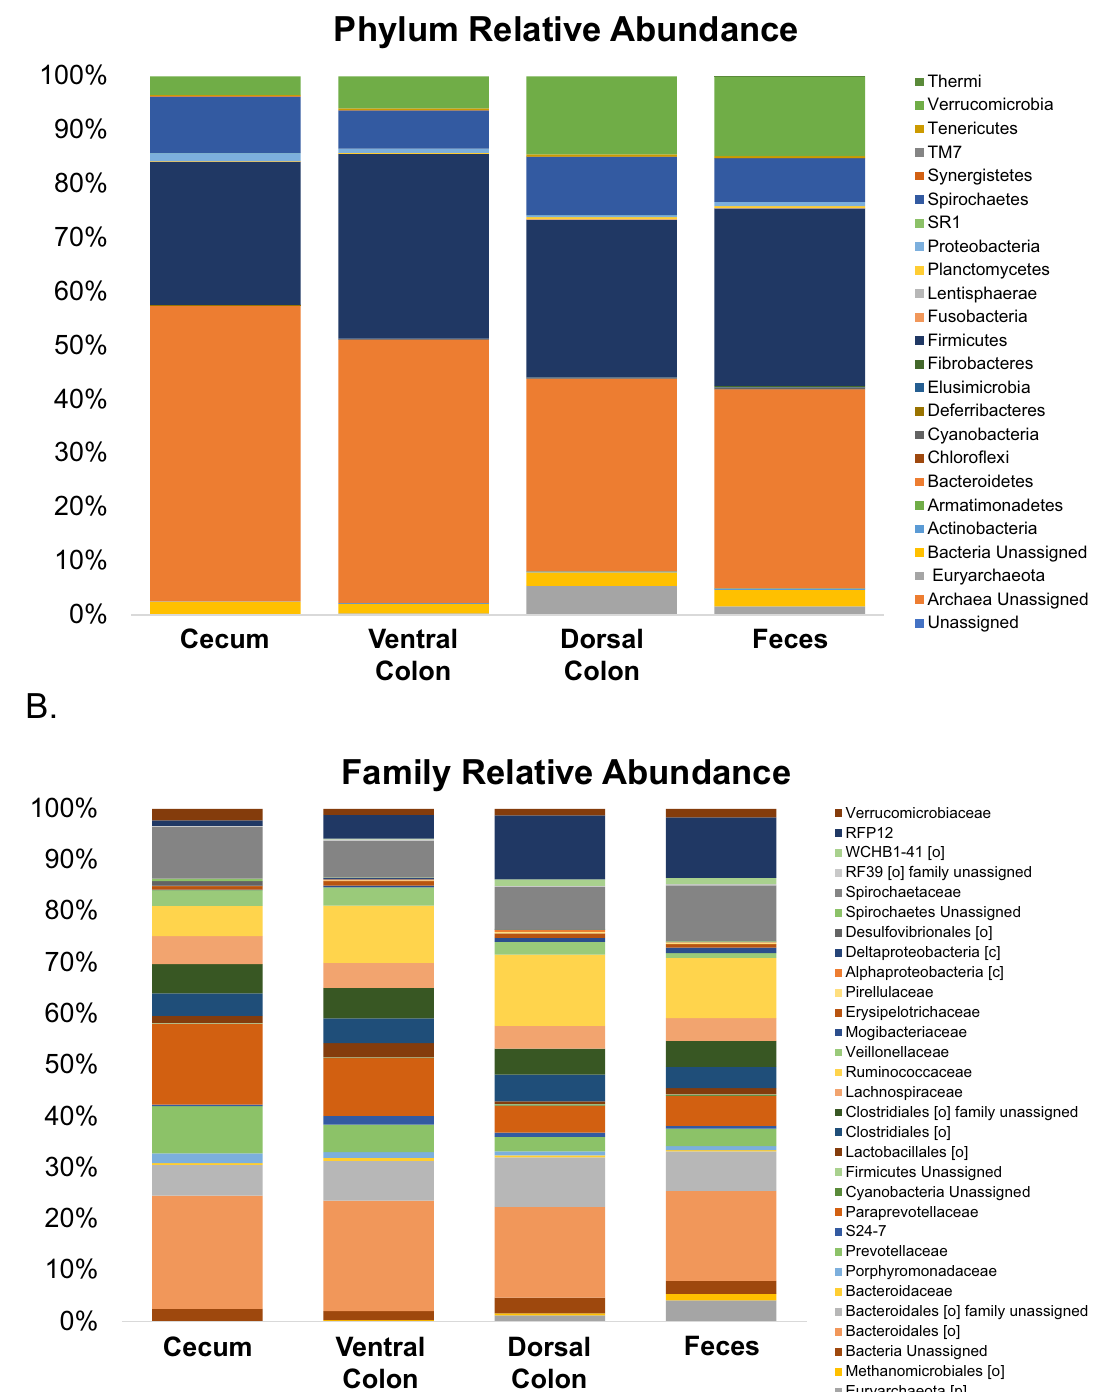
Figure 2. Relative abundance of microbial communities identified in the cecum, right ventral colon, right dorsal colon and feces, assigned to the phylum ( A ) and family level ( B ). For the family relative abundances, this figure depicts the top 30 features in the category, The complete list of families identified is available in Table